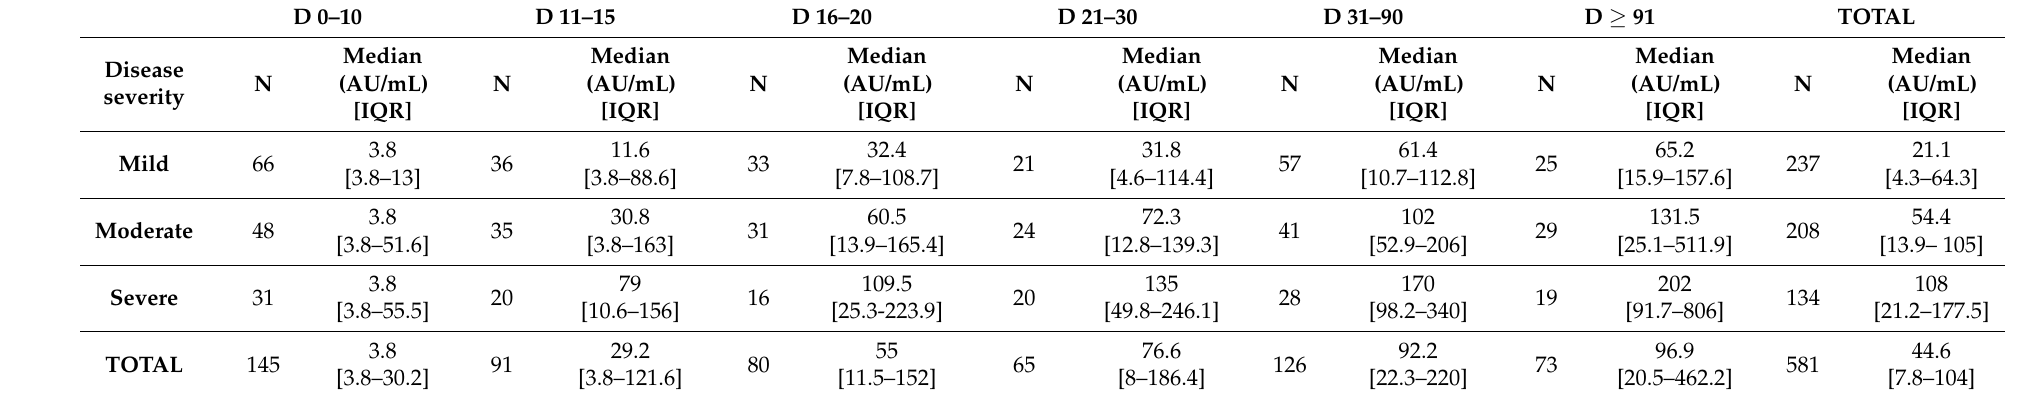
Table 6. Median antibody concentration detected by CLIA IgG antiS1/S2 according to the disease severity and time PSO